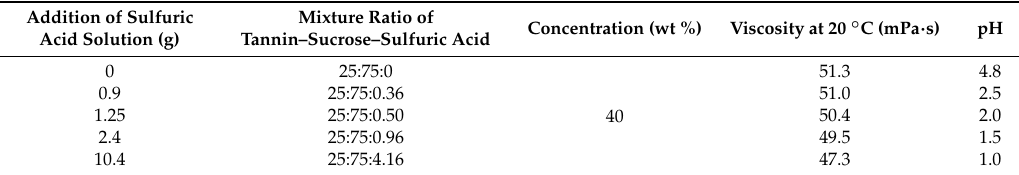
Table 1. Viscosity and pH of the tannin–sucrose–sulfuric acid solution. Addition of Sulfuric Mixture Ratio of Concentration (wt %) Viscosity at 20 ◦ C (mPa · Acid Solution (g) Tannin–Sucrose–Sulfuric Acid